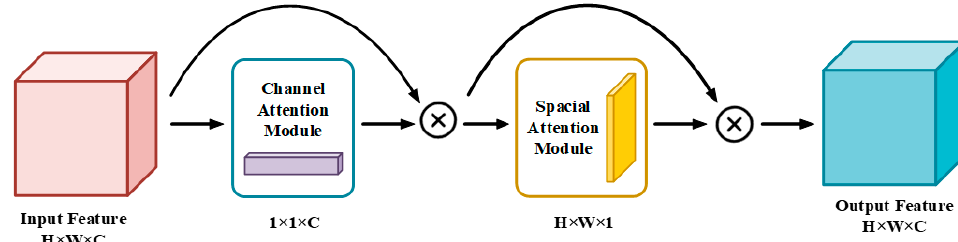
Figure 5. Convolutional block attention module.